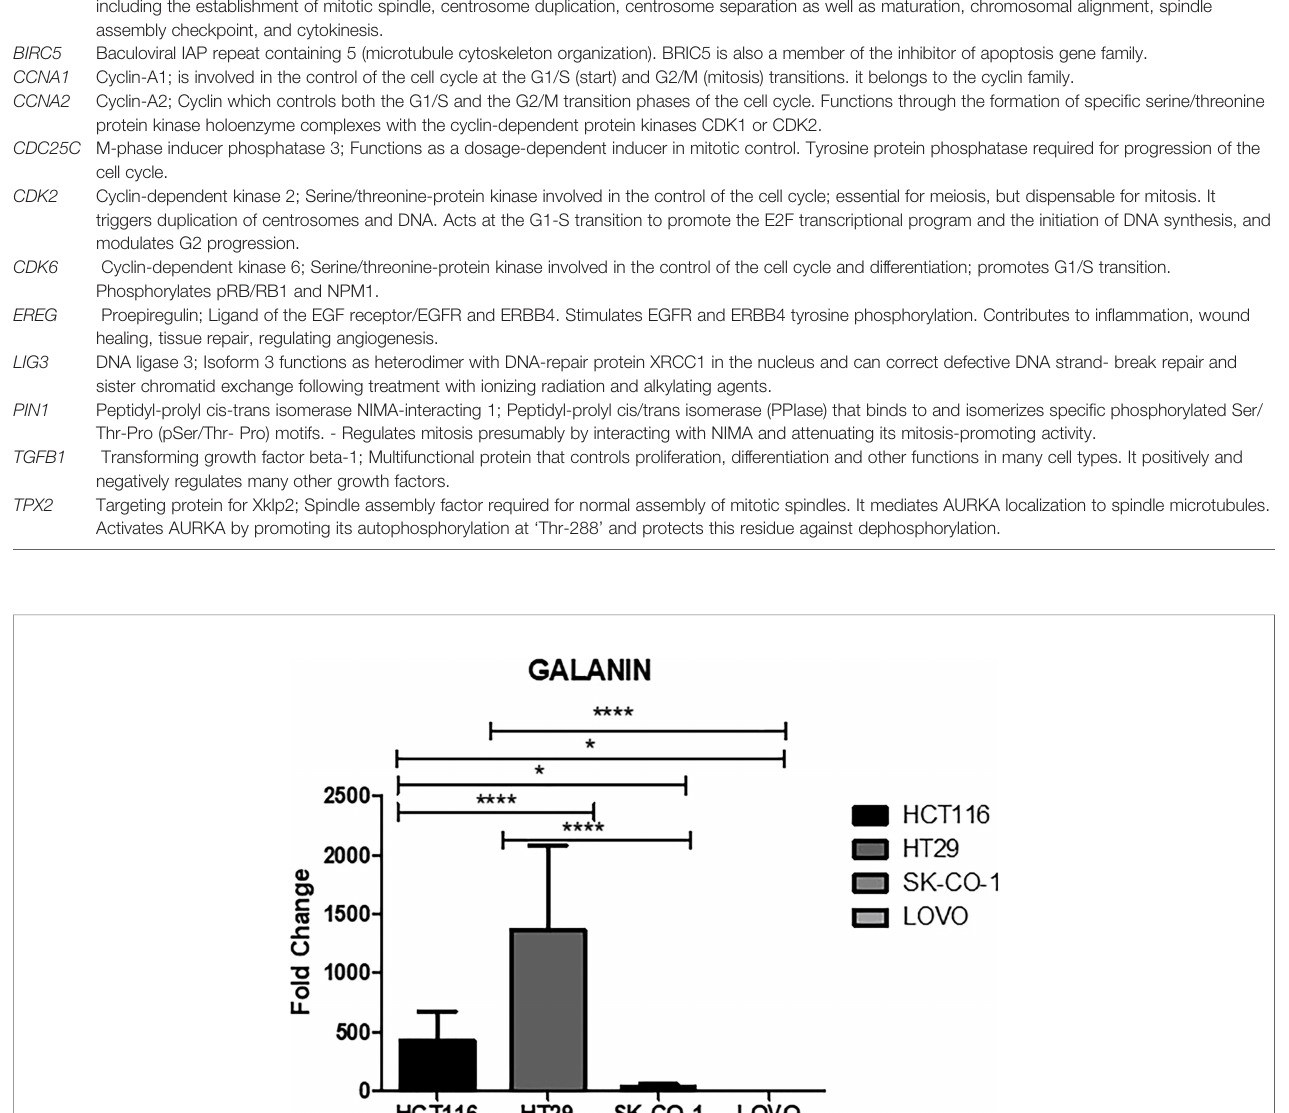
TABLE 2 | Most frequently shared genes among top differentially upregulated pathways in late CRC. Gene Annotation AURKA